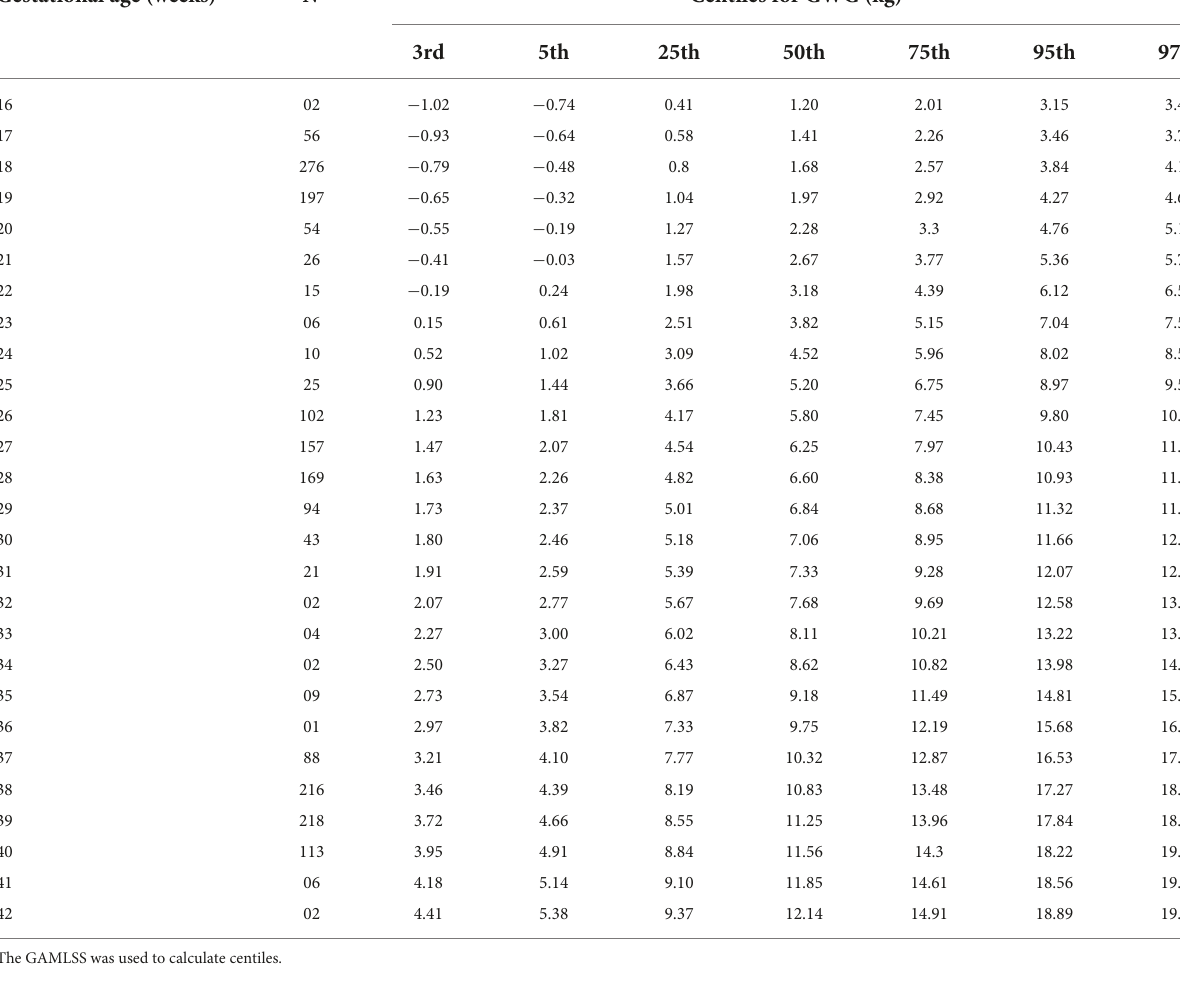
TABLE 2 GWG distribution (in kg) across pregnancy in the REVAMP cohort, Pune, India (primary analytic sample; n = 640). Gestational age (weeks) Centiles for GWG (kg)